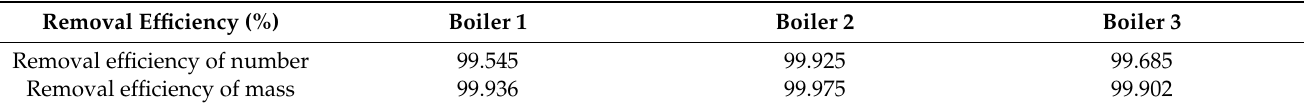
Table 7. Total removal efficiency of number/mass of fine particles emitted by CFB boiler.